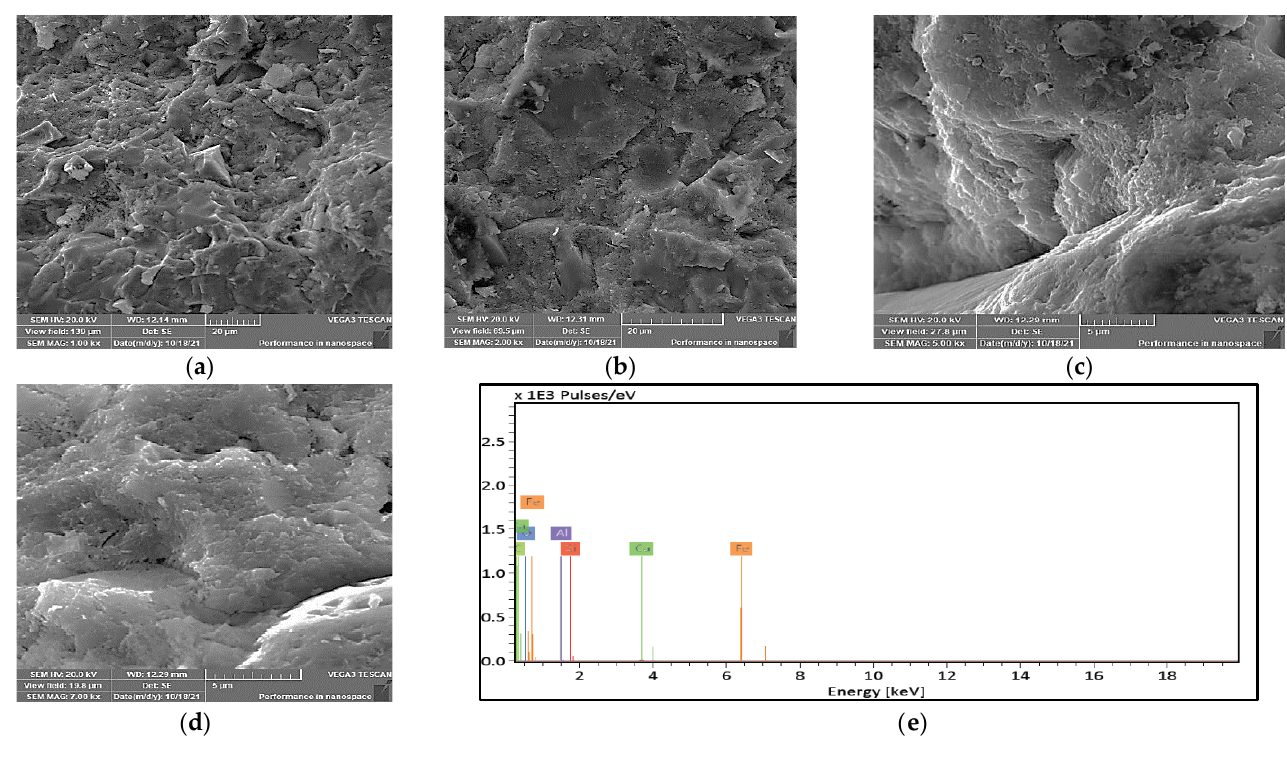
Figure 13. SEM with various magnification factors ( a – d ); ( e ) EDX for the control mix at hot curing temperature.